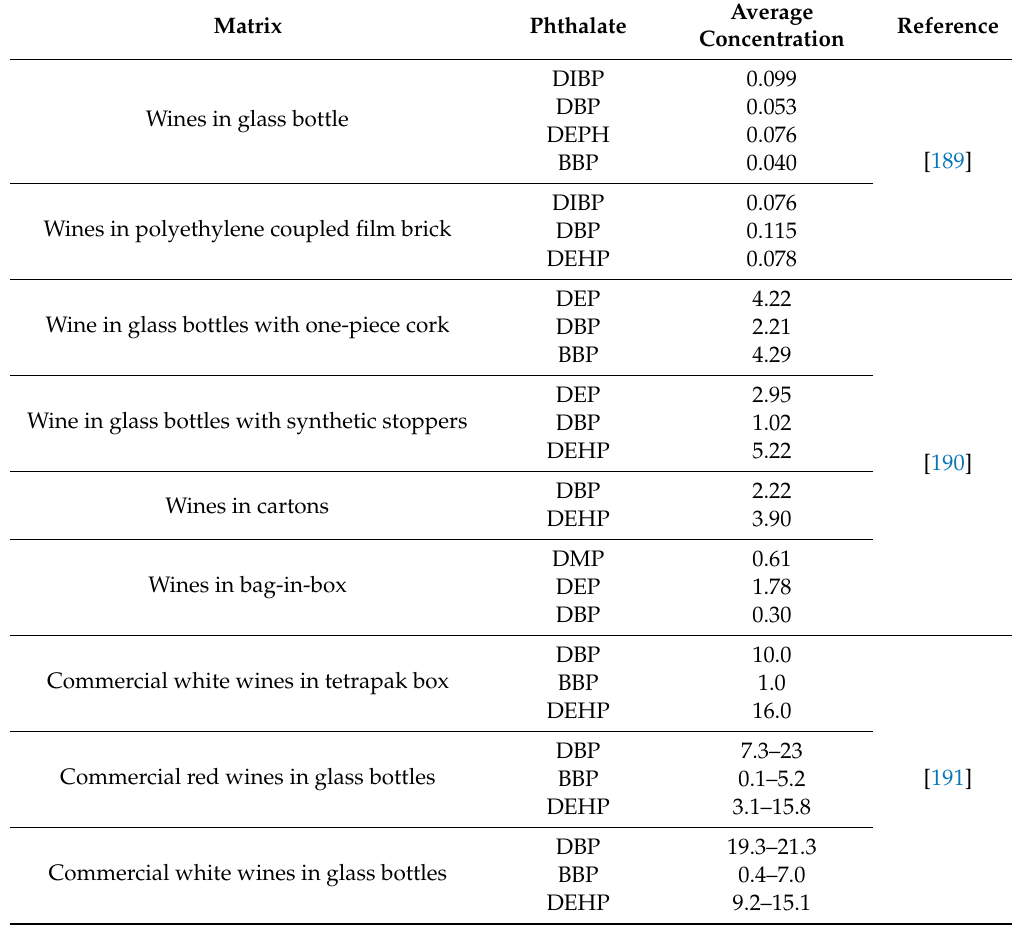
Table 3. Occurrence of phthalates in alcoholic beverages ( µ g L − 1